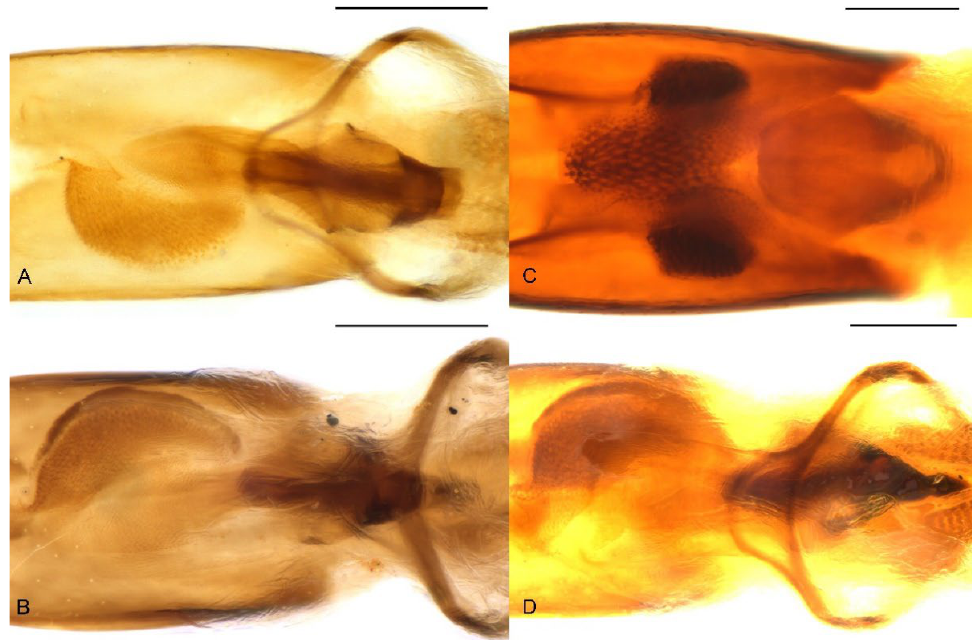
Figure 10. Endophallus of Miltotranes : ( A ) M. prosternalis , north of Cairns (Cape Tribulation), dorsal view; ( B ) ditto, south of Cairns (Mission Beach), dorsal view; ( C ) M. subopacus , dorsal view; ( D ) M. wilsoni sp. n., dorsal view. Scale bars: 0.2 mm.